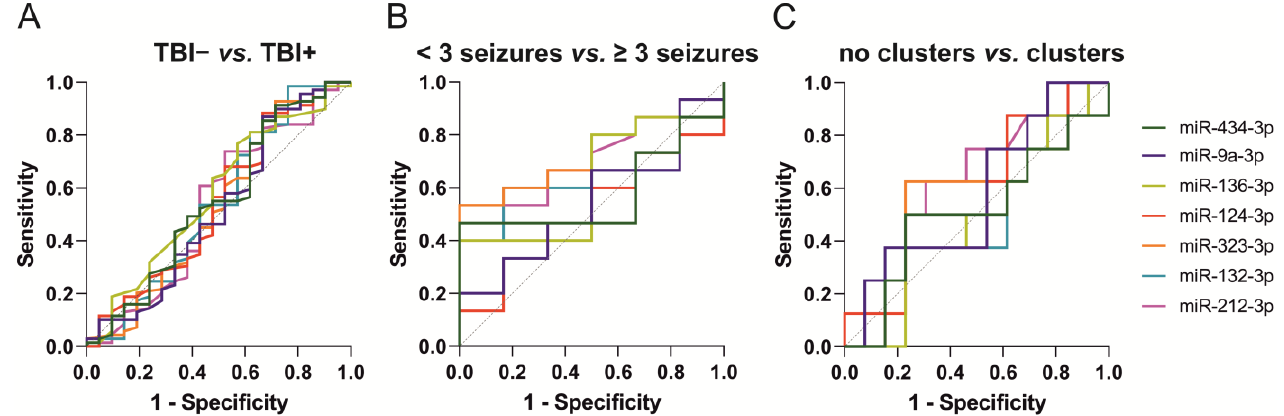
Figure 7. ROC analysis of plasma miRNA levels measured on D2 between epilepsy severity groups. None of the plasma miRNAs measured on D2 after traumatic brain injury (TBI) differentiated: ( A ) TBI rats with epilepsy (TBI+, n = 21) from rats without epilepsy (TBI − , n = 69); ( B ) TBI+ rats with ≥3 seizures ( n = 15) from TBI+ rats with <3 seizures ( n = 6); and ( C ) TBI+ rats with seizure clusters ( n = 8) from TBI+ rats without seizure clusters ( n =